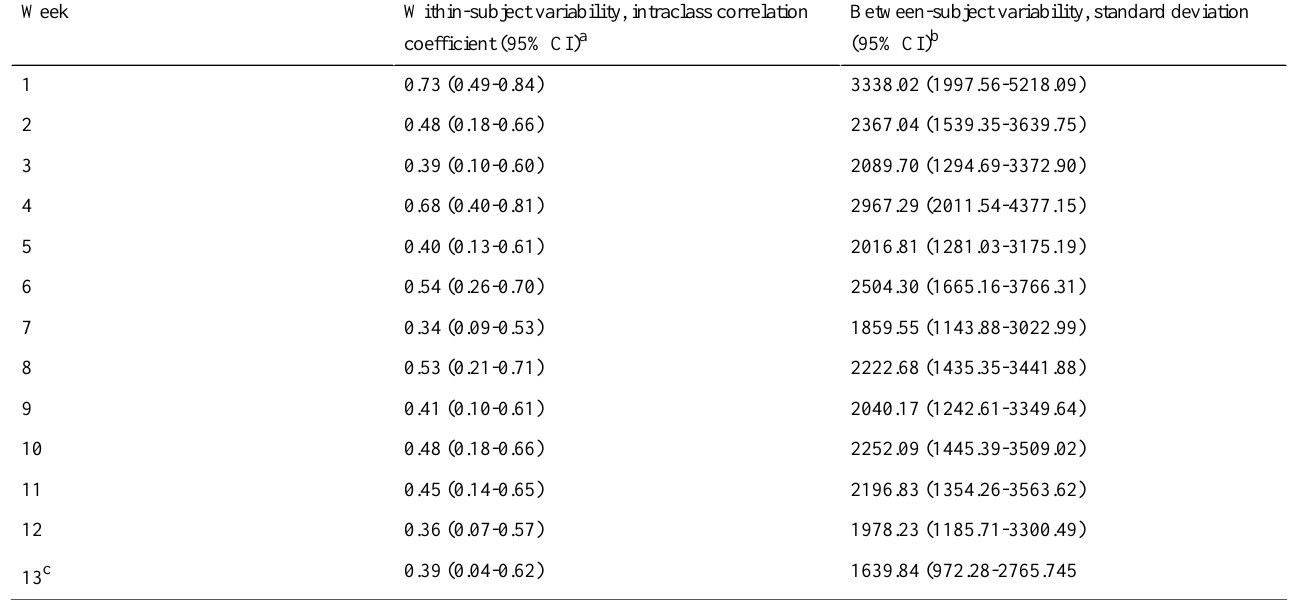
Table 3. Variability in weekly step counts.